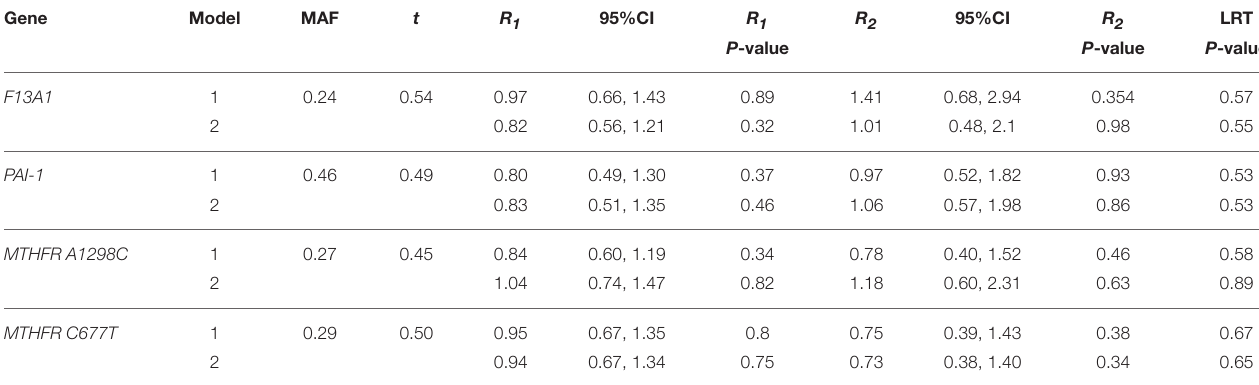
TABLE 4 | Relative risk with 95% CI, P -values, and LRT P -values of models 1 (Unadjusted) and 2 (Adjusted) for 4 thrombopilic genes ( F13A1, PAI-1, MTHFR A1298C, and MTHFR C677T ), With MAF and transmission ratio ( t ), on an intrauterine growth restriction dataset collected from a Canadian hospital between 1998 and 2000.